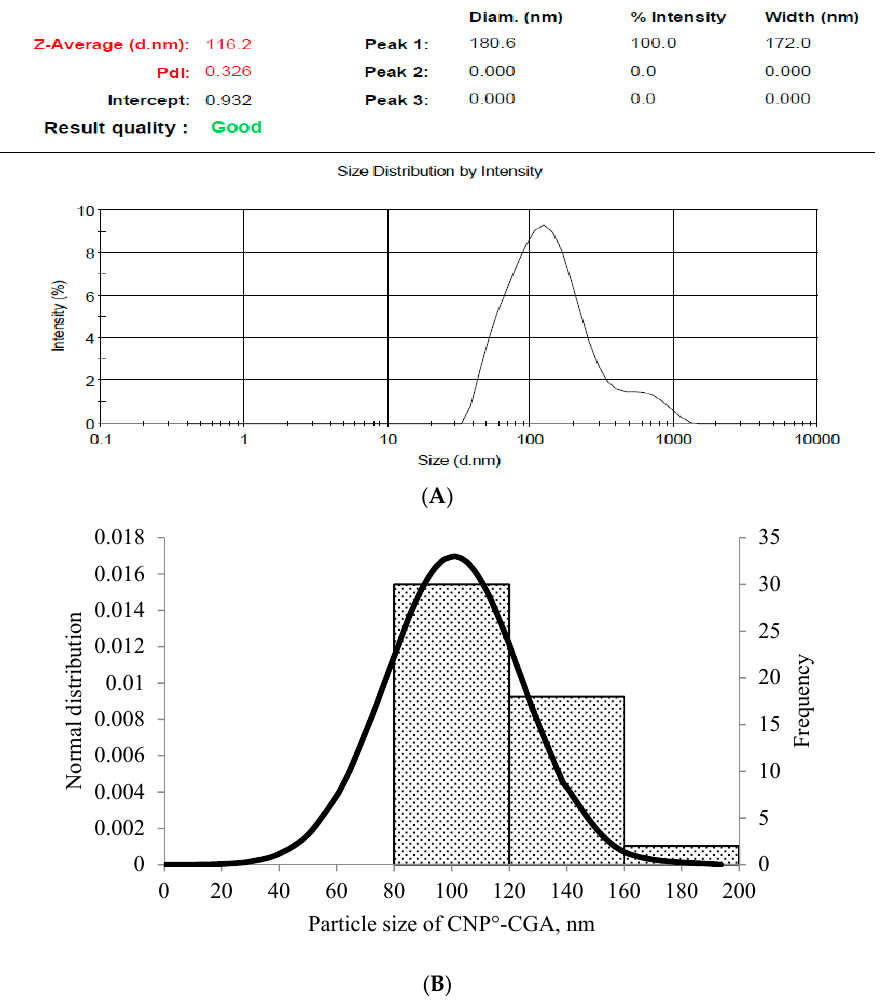
Figure 8. ( A ) DLS result of CNP°-CGA and ( B ) normal distribution and frequency graphs of CNP°-CGA particle sizes (nm) obtained by measuring particle size in FESEM image in (Figure 6B) using ImageJ software. Comparable particle size range of CNP° was observed between DLS (134.44 ± 18.29 nm) and FESEM (80 nm to 160 nm). The slight difference between the two analysis is because DLS measures the particle size in hydrodynamic condition, while FESEM measures in a dry condition.